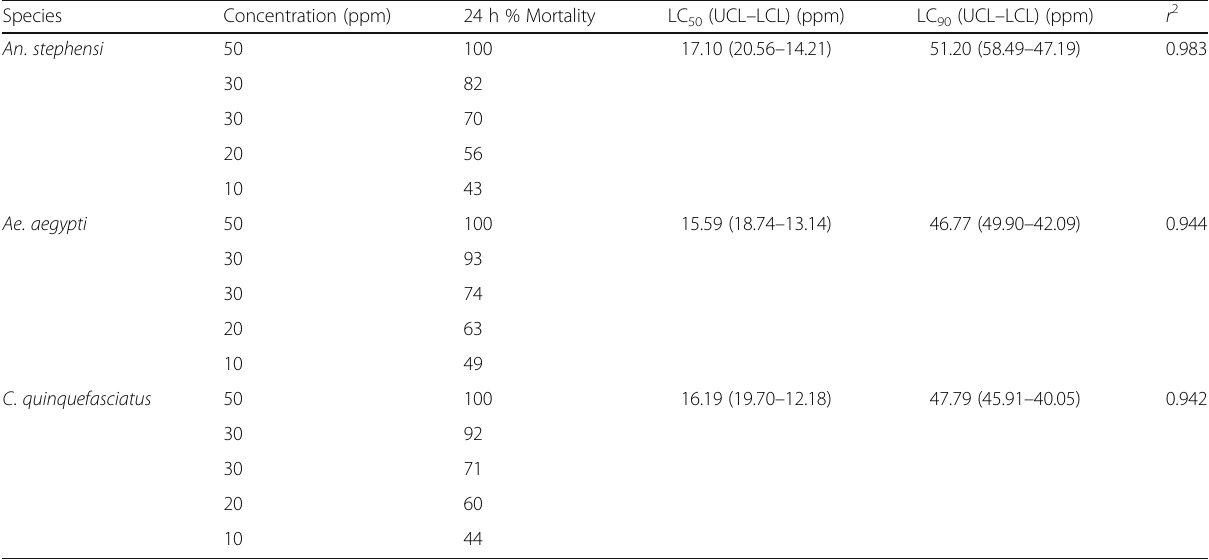
Table 1 Larvicidal activity of oil extract of Leucas aspera against malaria, dengue, and filariasis vectors Species Concentration